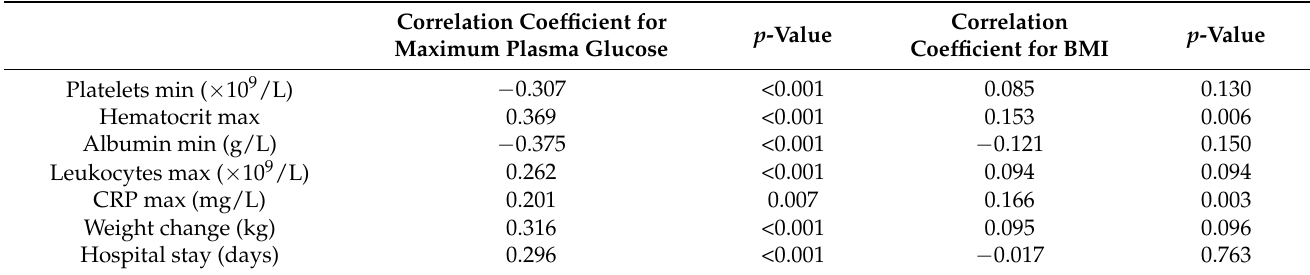
Table 3. Correlation coefficients of variables reflecting disease severity with maximum plasma glucose and body mass index